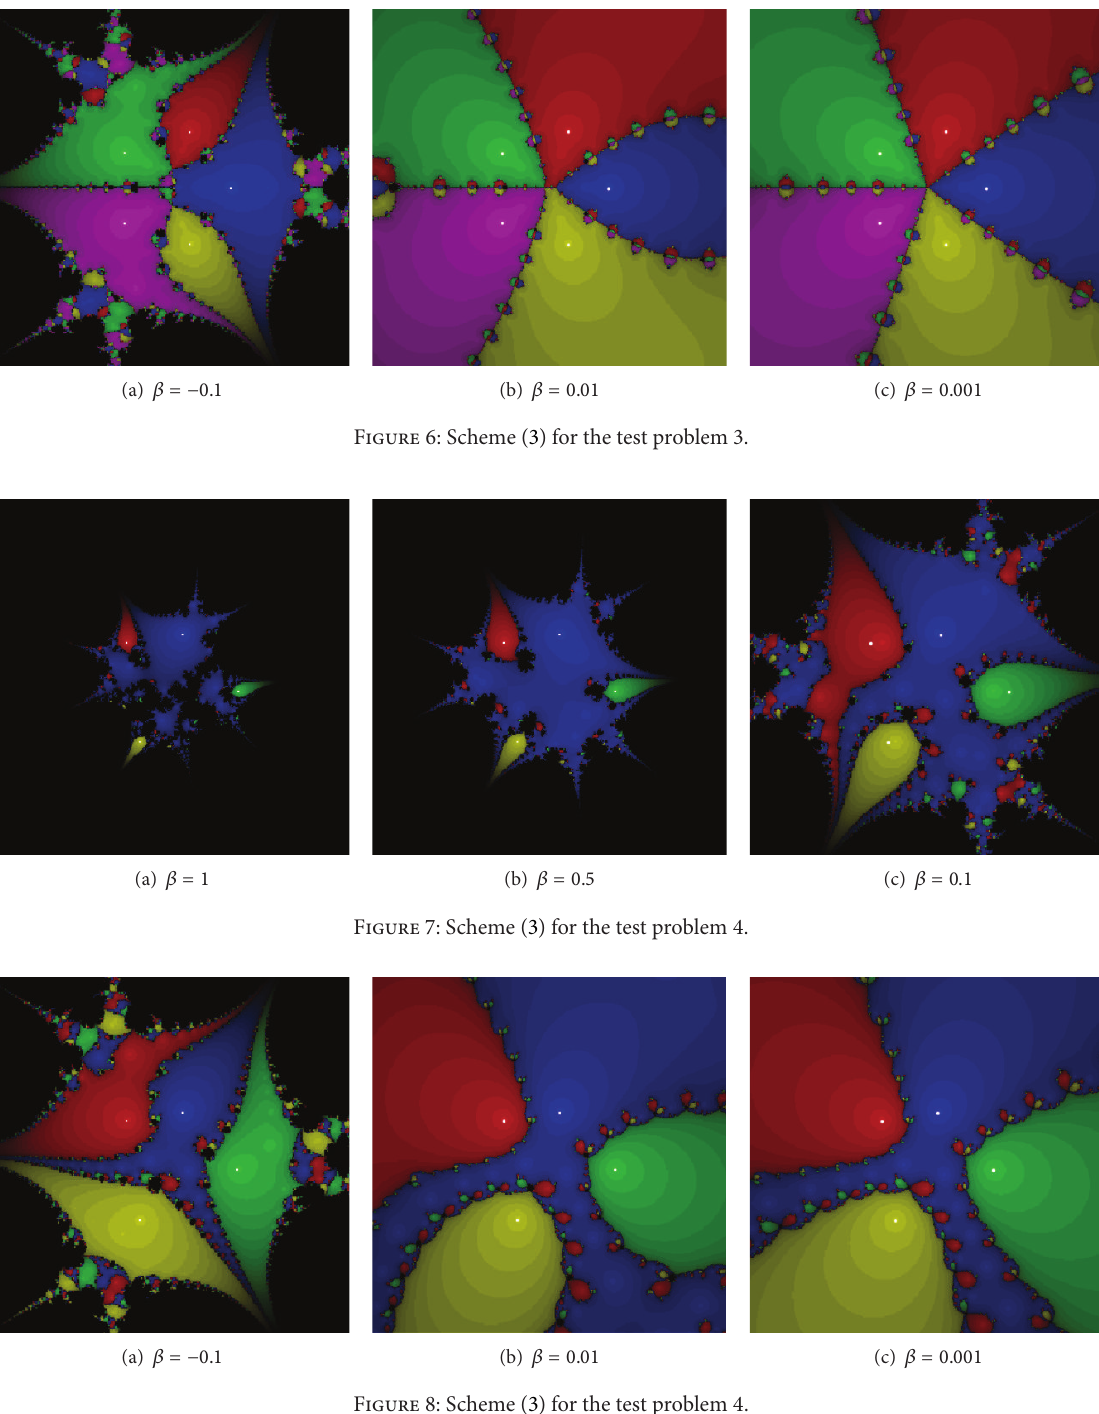
Figure 8: Scheme (3) for the test problem